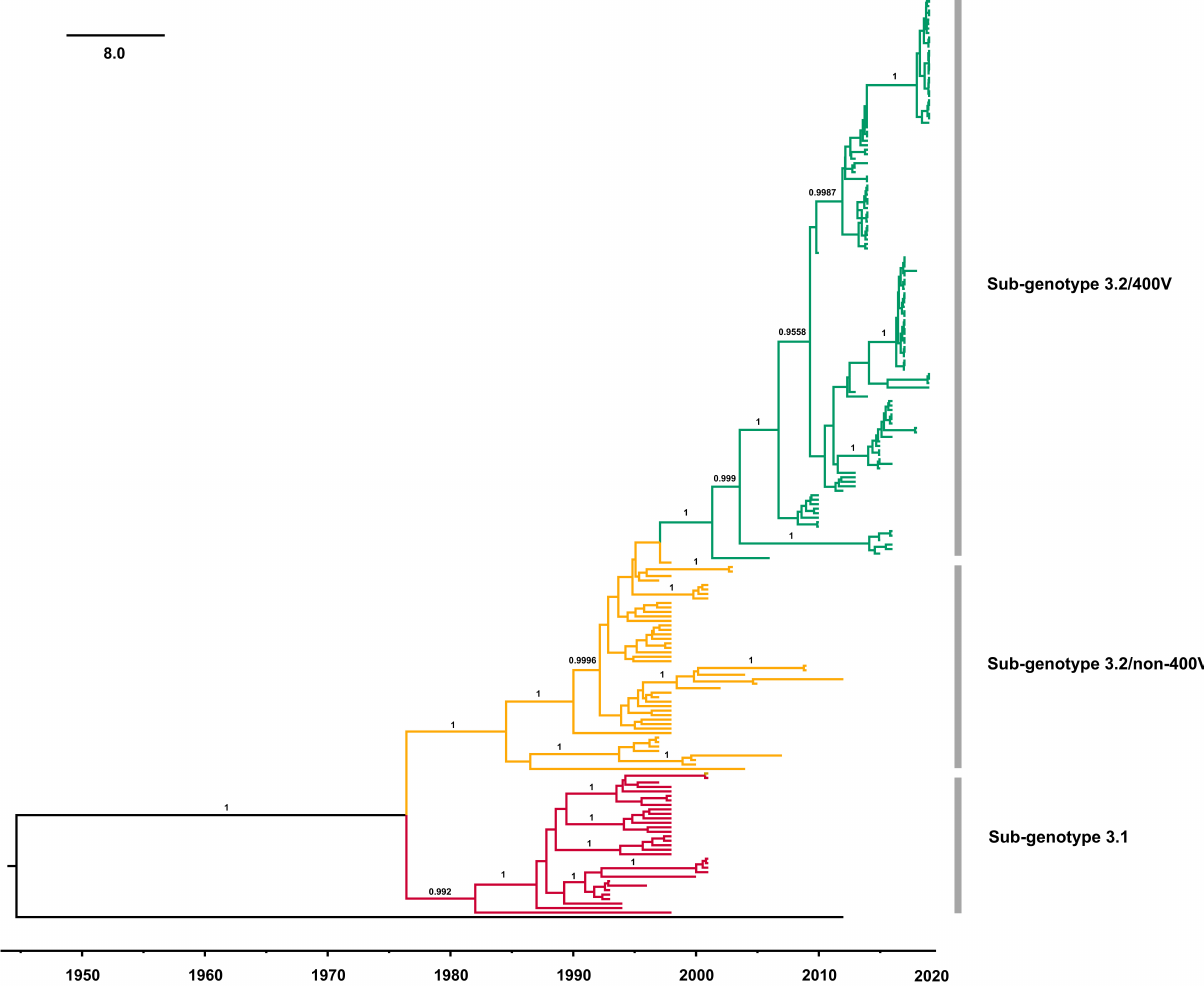
Figure 4. Phylogenetic tree of MeV genotype B3’s H gene, constructed by the Bayesian Markov chain Monte Carlo method. The scale bar represents the unit of time (year), and the divergence times of sub-genotypes were added. The sequence from genotype D4 (MVi/California, USA/16.12) was used as an